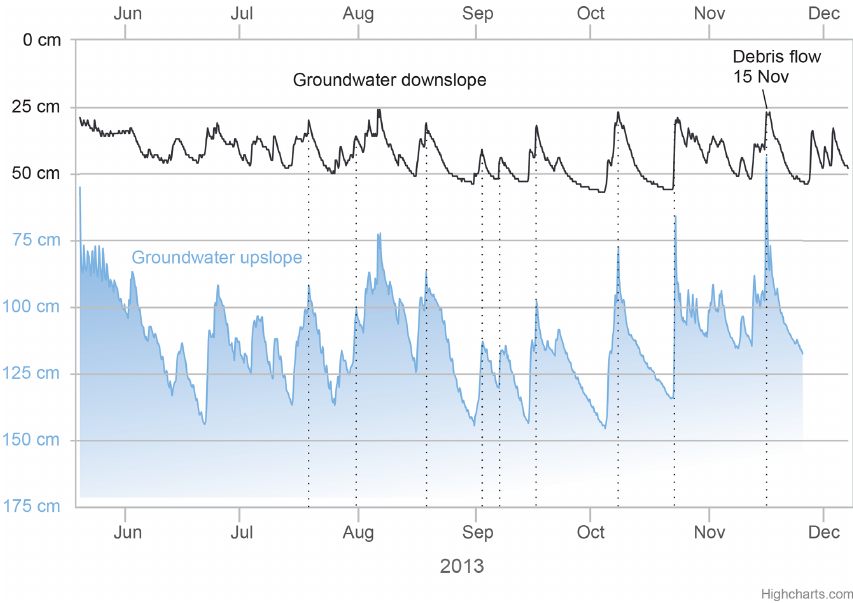
Figure 7. Groundwater fluctuations in June–December 2013. The upper curve (black) shows fluctuations at the weather station in the valley bottom. The blue curve shows the fluctuations in the borehole upslope. The minima and maxima occur at the same time (dotted lines), but the peaks upslope are sharper, last less than 4h and have higher amplitudes, and the individual peaks reach different levels. The ground in the valley bottom is saturated at a registered depth of around